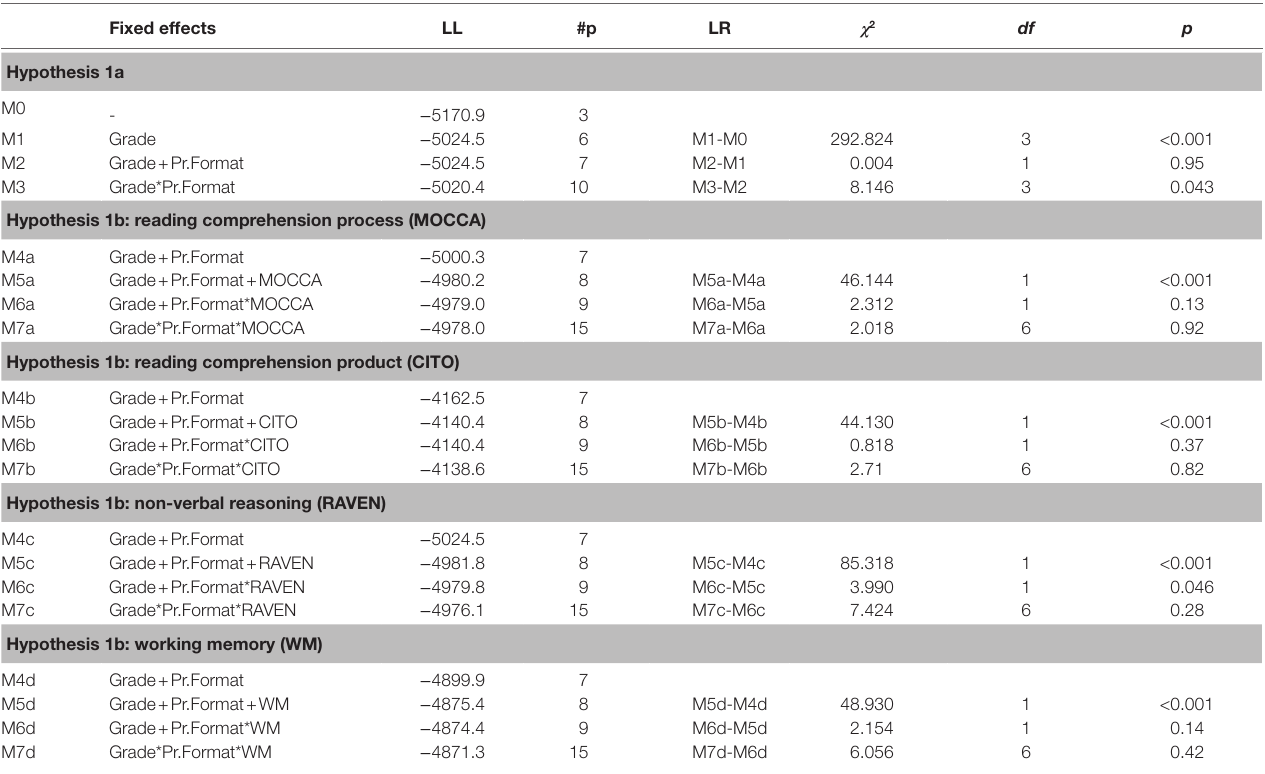
TABLE 4 | Statistical tests for research question 1: standard word problems versus symbolic problems.